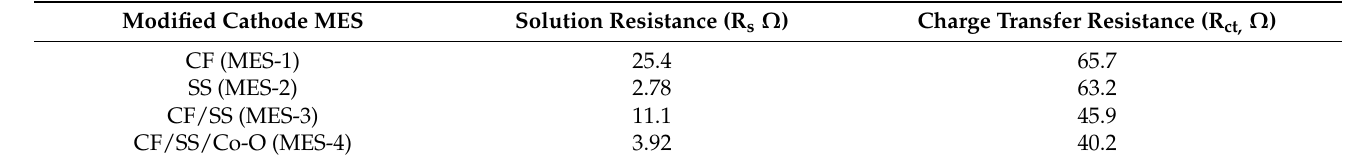
Table 3. Different resistance components obtained from the Nyquist plot for different